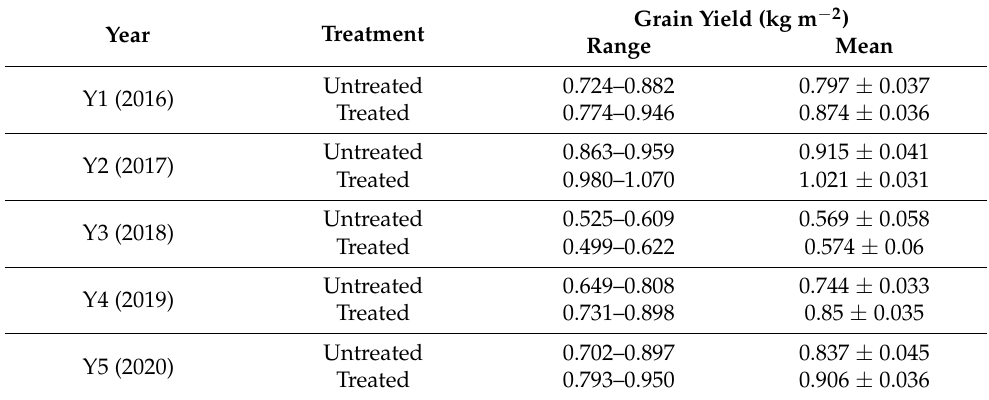
Table 1. Variation in grain yield (kg m − 2 ) across five years under treated and untreated